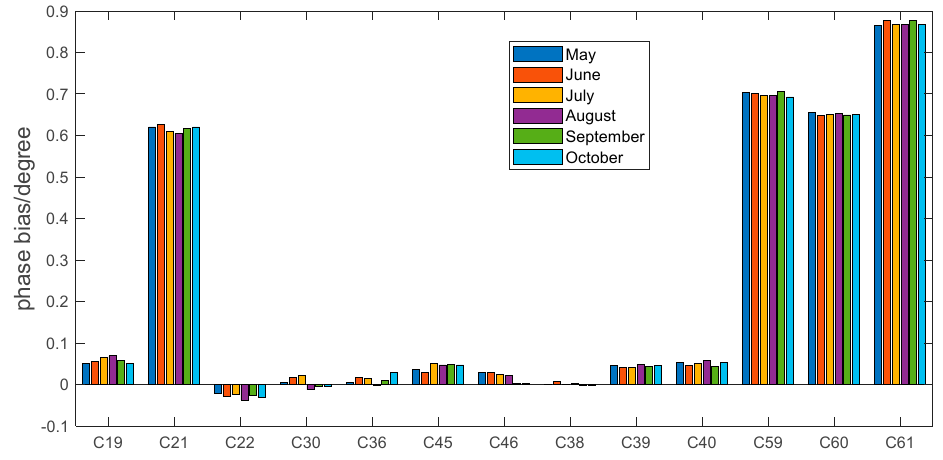
Figure 15. Carrier phase bias between data and pilot of B2a signal in 2022.